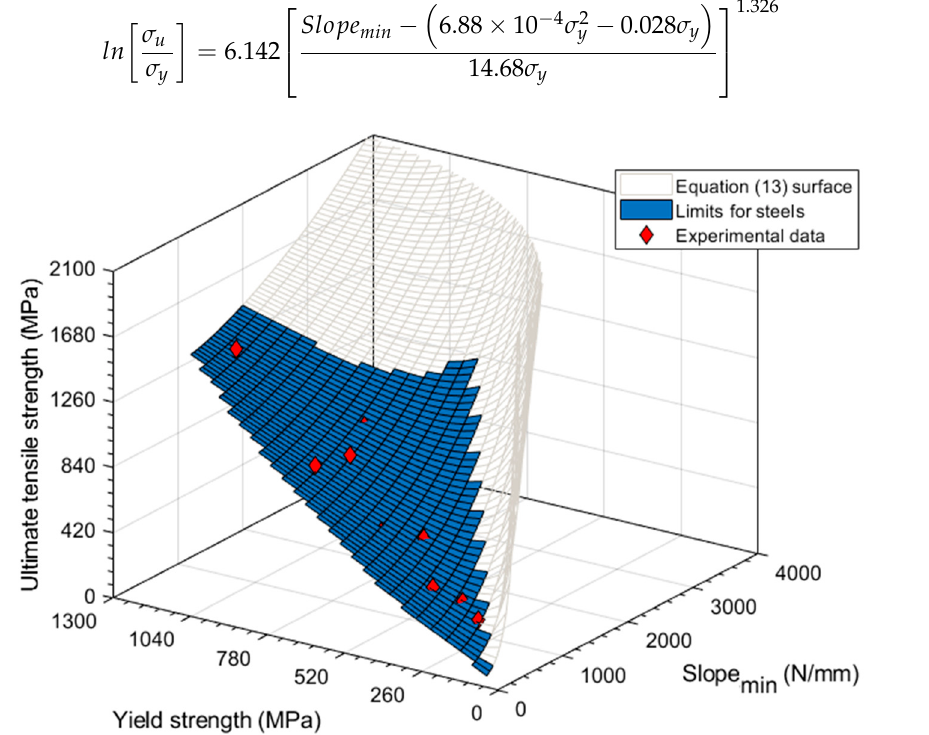
Figure 15. Ultimate tensile strength correlation obtained with Matlab ® for the experimental data.